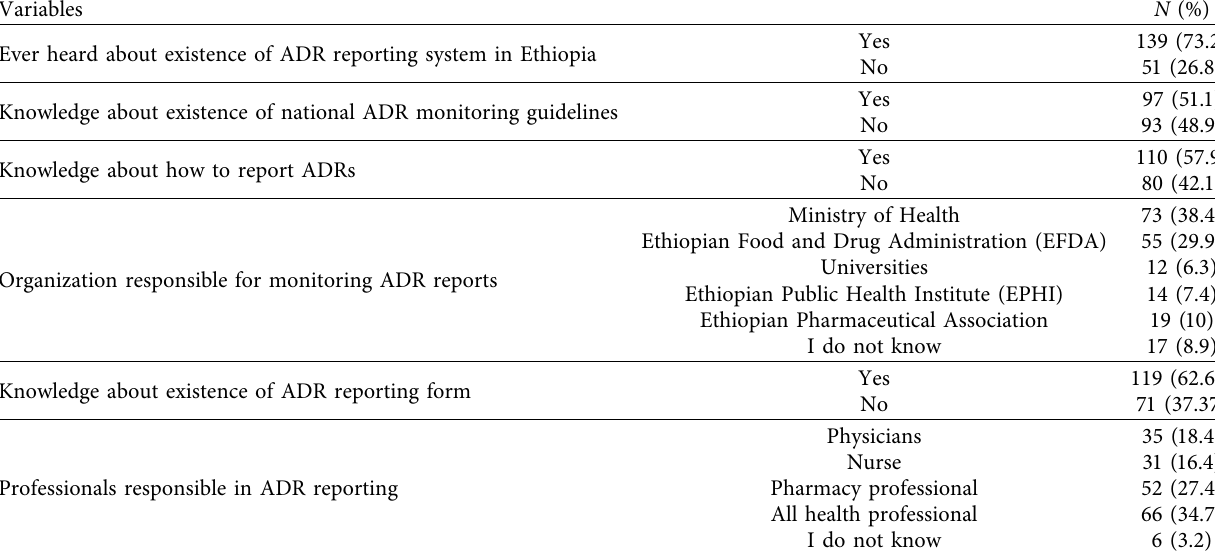
Table 3: Knowledge of healthcare providers towards ADR reporting in Mizan Tepi University Teaching Hospital from August to September 2021.